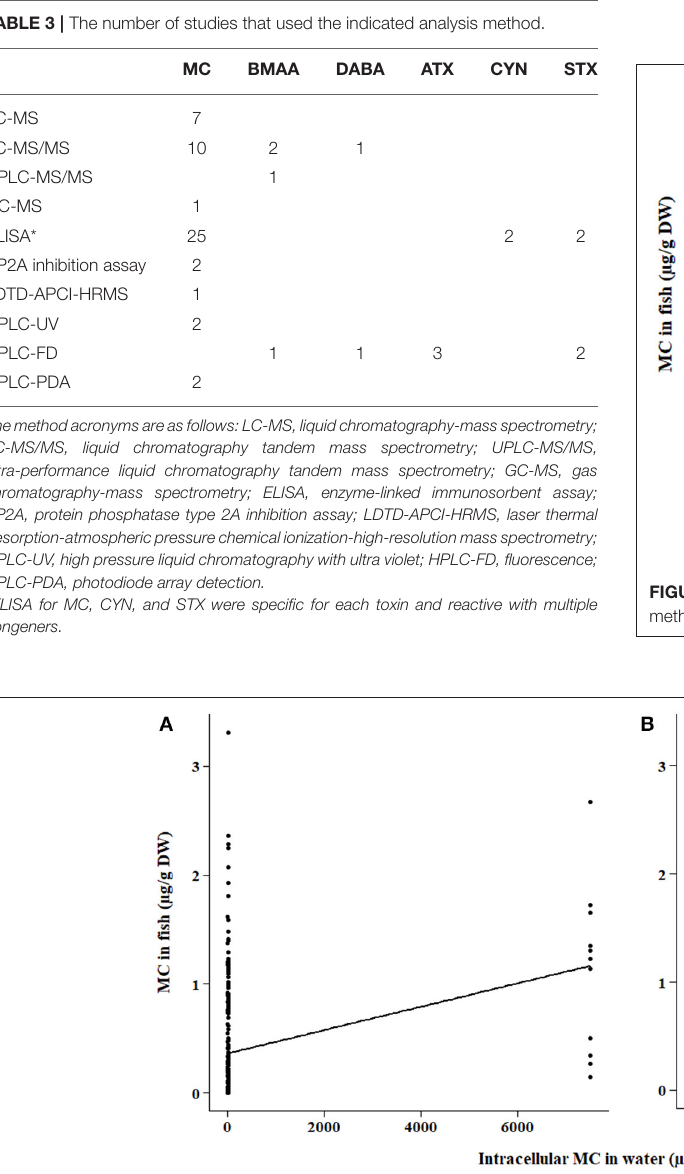
FIGURE 2 | (A) Microcystin (MC) in fish tissues as a function of intracellular MC concentration in the water for samples quantified by the ELISA method. Fish tissues include all tissue types and fish feeding modes. (B) Same data as (A) but with focus on intracellular MC concentrations below 20 µ g/L.